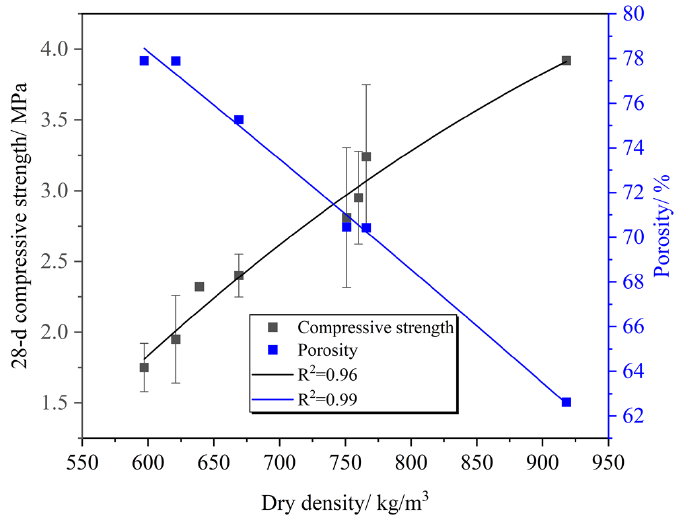
Figure 2. Relationship between the 28 d compressive strength and porosity and dry density.